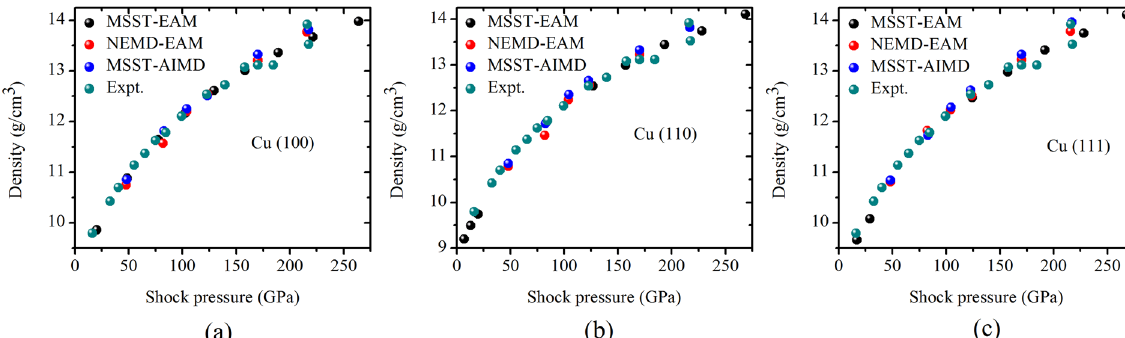
Figure 1. Shock Hugoniot point, pressure and density of the target sample with desired orientation (i.e. 〈 100 〉 , 〈 110 〉 and 〈 111 〉 ) has been measured for all sets of simulations [MSST (utilizing EAM potential), NEMD (utilizing EAM potential) and ab − initio molecular dynamics (AIMD)] and compared with the available experimental shock Hugoniot data points 37 for poly-crystalline Cu. The above figures represent shock data for different shock directions, ( a ) 〈 100 〉 , ( b ) 〈 110 〉 and ( c ) 〈 111 〉